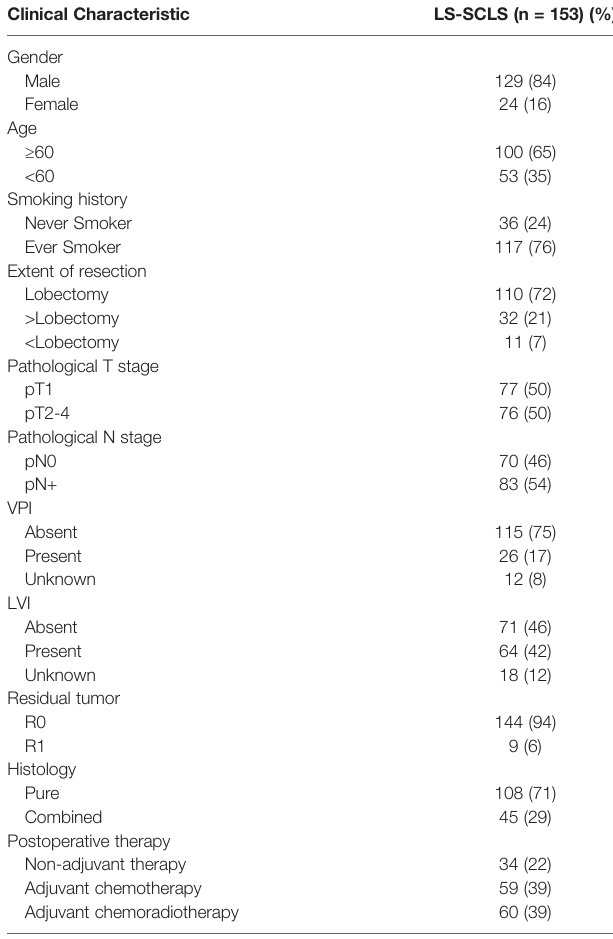
TABLE 1 | Characteristics and adjuvant therapy